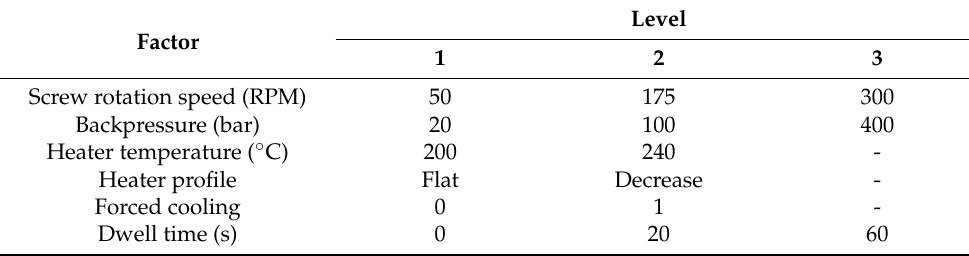
Table 1. Experimental conditions using HDPE.